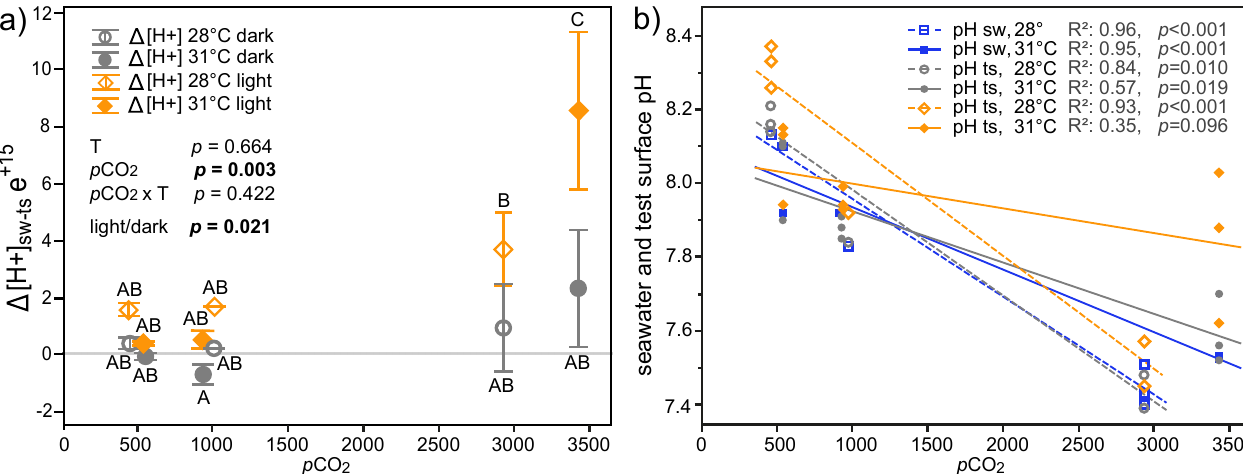
Figure 1. Changes in ( a ) ∆ [H + ], i.e., the difference in proton concentration between the seawater (sw) and the test surface (ts) (n ≤ 3) and ( b ) pH at the test surface of Amphistegina lobifera and the seawater (blue rectangles) in response to p CO 2 crossed with 28 °C (open) or 31 °C (filled), measured by pH microelectrode during exposure to light (yellow diamonds) and dark (grey circles). ( a ) PERMANOVA p -values are given for two-way analysis of the effects of p CO 2 (C = 492 ppm, M = 963 ppm, H = 3182 ppm) and temperature (T: 28 °C, 31 °C), as well as for one-way analysis of the effect of light vs. dark. Bold values indicate significant effects ( p < 0.05). Treatments lacking common capital letters are significantly different in pair-wise comparison of all ∆ [H + ], corrected for multiple testing at an FDR threshold of 0.1. ( b ) Lines represent linear regressions for each treatment under light/dark conditions, with R 2 indicating coefficient of correlation and respective p -values of F-test statistic (n ≤ 3).